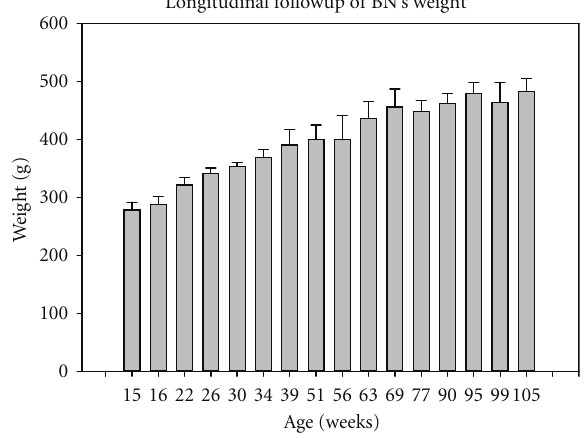
Figure 5: Follow-up of BN’s weight as a function of aging. Standing from 278 ± 13 g up to 482 ± 22 g, it was observed to significantly increase with age ( P < 0 . 001), but was observed to stabilize from around 60 weeks old ( P = 0 .